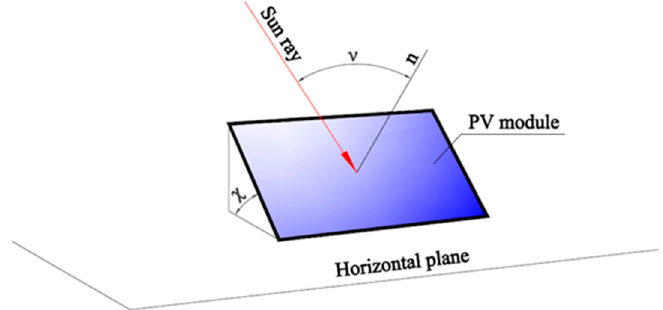
Figure 1. The tilt angle ( χ ) of a fixed PV module and the incidence angle ( ν ) between the Sun ray and the normal (n) of the PV module.